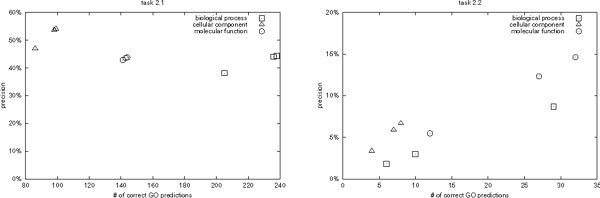
Performance of FiGO in each class of the GO hierarchy in tasks 2.1 and 2.2. For each class of the GO hierarchy, these charts compare the performance of the three submissions of FiGO to BioCreative tasks 2.1 and 2.2. For each class, the charts show the precision versus the number of correct GO predictions identified by each submission. The precision is the number of correct GO predictions over the number of predictions submitted.